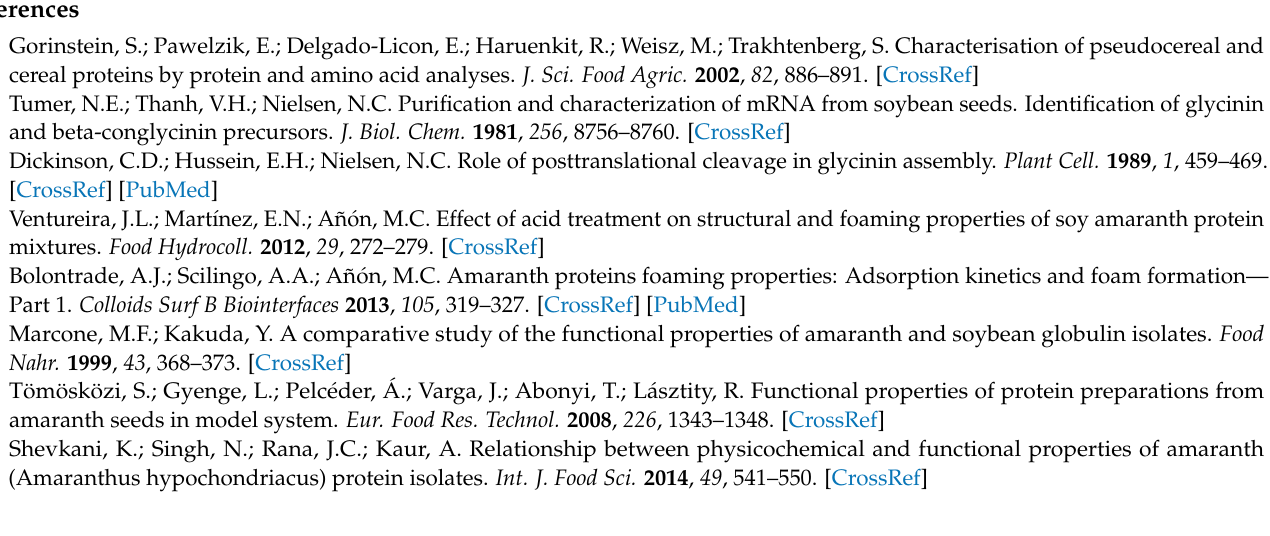
purified. Figure S2. AAC and their modified versions models predicted using AlphaFold Colab. Arrows indicate peptides inserted in each version [37]; Figure S3. Superpose of models obtained using AlphaFold. Ovals indicate the main regions in which were observed the most conformational differences. Black arrow indicate C-terminal region compacted in AACM.4 which increased beta content [38]; Table S1. Percentage estimation of the secondary structure content from the CD spectra of AAC and the modified